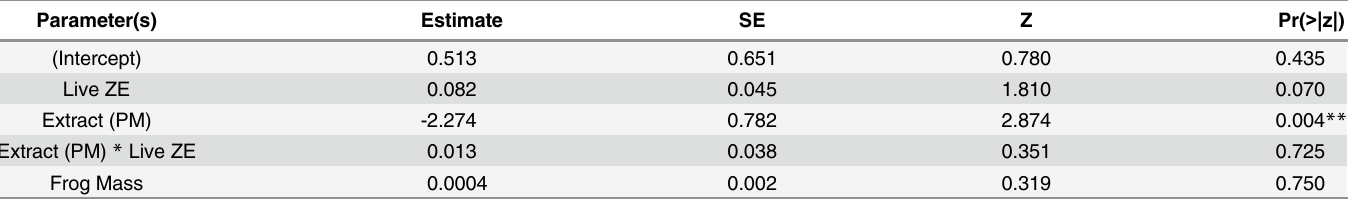
Table 3. Results of model averaging for three best-fit (within 2 AIC) models for the dependence of frog parameters on the probability of Bd detec- tion as response variable in generalized linear mixed models, (Table 2; n = 52 frogs, 104 samples). Individual frog ID was included as a random factor. Individuals without mass data available (n = 6) were excluded from the analysis.